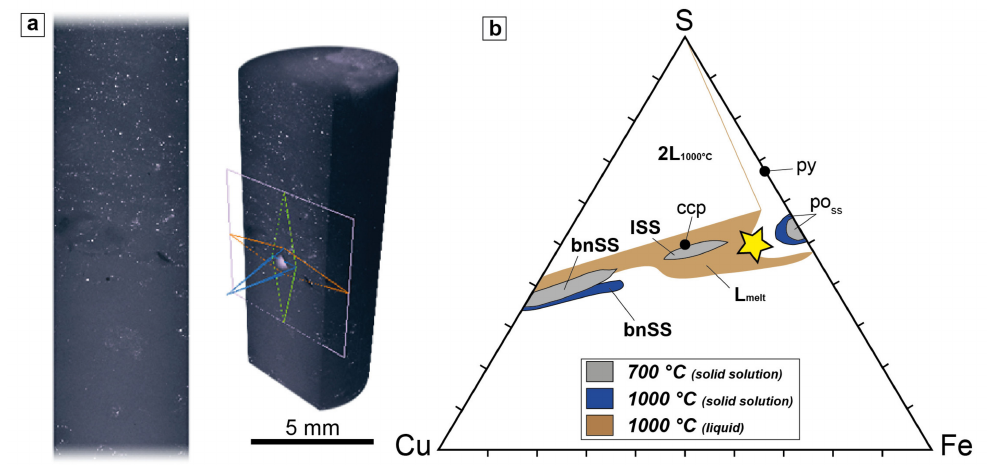
Figure 8. ( a ) Slices of the composite porcellanite–buchite xenolith of Stromboli through the 3D X-ray µ CT data for a 5 mm diameter core (high resolution 2.3 µ m voxel size). They show the sulphide globules (as bright spots) in xz planes as we see flying through the 3D data in the video (see Video S1) where their abundance is far larger than how it appears on a 2D polished section surface due to steric effects (polished sections only expose minerals at a single surface so that fine particles beneath the immediate surface are not visible); ( b ) phase relations in the Cu–Fe–S system at 700 ◦ C and 1000 ◦ C from Vaughan and Craig [83] adapted from Barton and Skinner [84]. L = liquid; SS = solid solution; bn = bornite; ISS = intermediate solid solution; py = pyrite; po = pyrrhotite; ccp = chalcopyrite. The yellow star is the approximate bulk composition of the sulphide globules quenched as immiscible liquid in the buchite portion of the B1 xenolith. The composition of the sulphide globules corresponds to a theoretical pyrrhotite—chalcopyrite tie